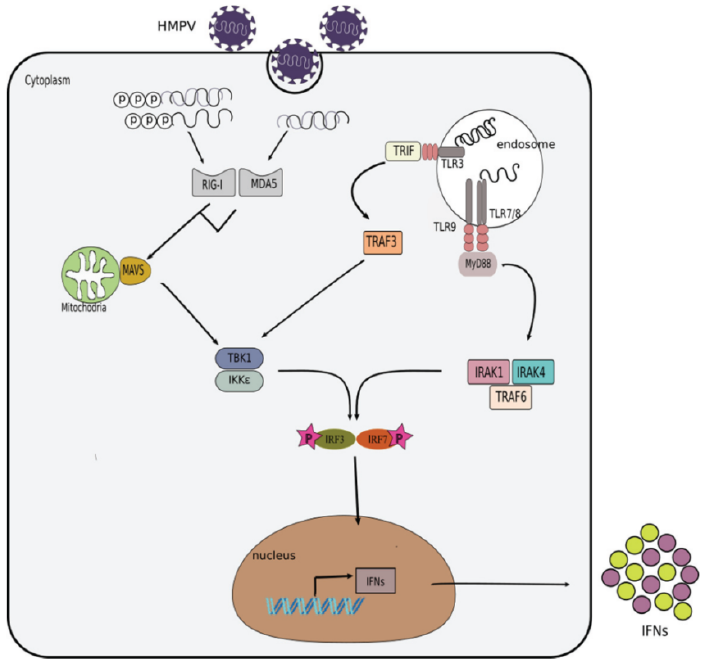
Figure 2. Induction of the interferon response by HMPV. During HMPV infection, its viral PAMPs are detected by toll-like receptors (TLRs) in the endosome and RIG-I-like receptors (RLRs) in the cytoplasm. Activation of TLR7/8 by ssRNA results in the recruitment of the adaptor molecule myeloid differentiation primary response protein 88 (MyD88). MyD88 further recruits and activates the interleukin 1 receptor associated kinases (IRAK1 and IRAK4) and the tumor necrosis factor receptor associated factor 6 (TRAF6) which in turn mediate the phosphorylation and activation of IRF7. Translocation of IRF7 into the nucleus triggers the expression of IFNs. In addition, dsRNA can be detected by TLR3 also in the endosome, which leads to the activation of TRAF3 and subsequent activation of the tank binding kinase-1 (TBK1)/I kappa B kinase epsilon (IKK ε ) kinases that eventually induce the phosphorylation of interferon regulatory factor 3 (IRF3) and IRF7. On the other hand, retinoic acid-inducible gene I (RIG-I) or melanoma differentiation associated factor 5 (MDA5) can be activated in the cytoplasm by 5 (cid:48) ppp-dsRNA, 5 (cid:48) ppp-ssRNA or long dsRNA, respectively. Activation of RIG-I or MDA5 subsequently activates the mitochondrial antiviral signaling protein (MAVS). MAVS recruits additional adaptor proteins that trigger the activation of TBK1/IKK ε kinases. TBK1/IKK ε phosphorylate IRF3/7 which then translocate to the nucleus to induce the expression of